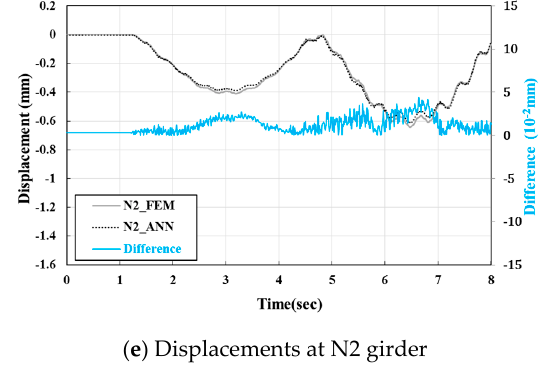
Figure 11. Test results at midpoint of girder for 40 km /